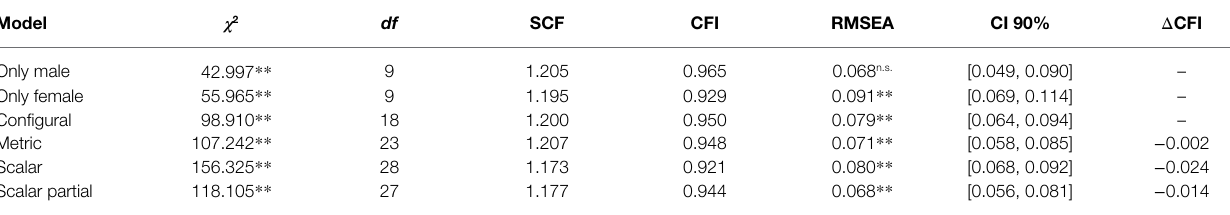
TABLE 8 | Multigroup measurement invariance of OB-GSE across gender.